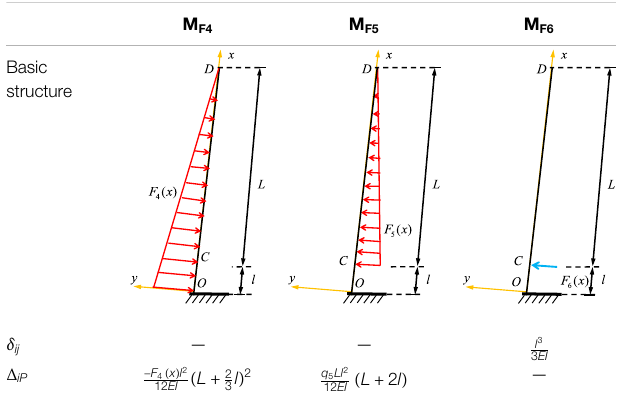
TABLE 2 | Bending moment diagram of the basic roof structure under different loads. M